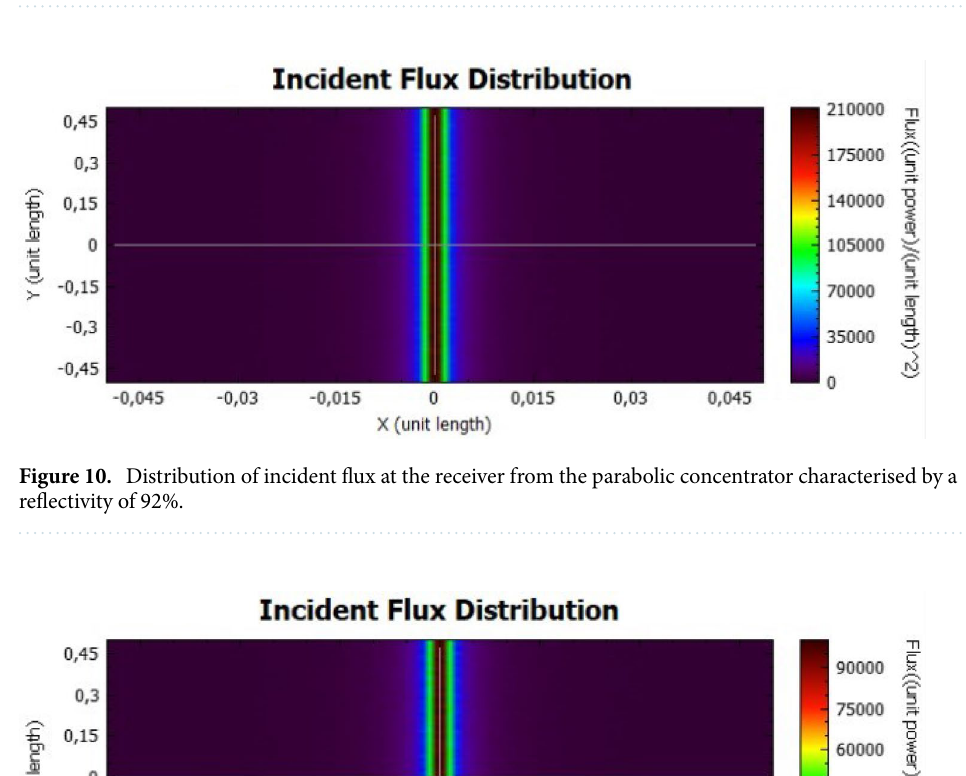
Figure 9. Distribution of incident flux at the receiver from the flat concentrator characterised by a reflectivity of 47%.